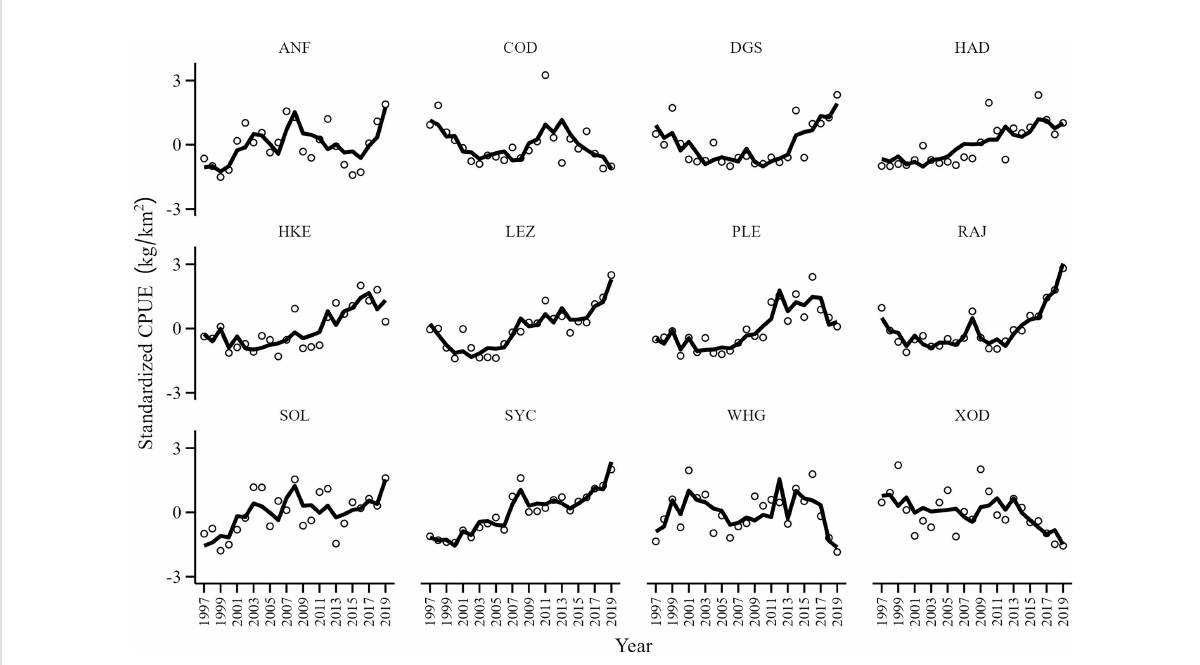
FIGURE 6 Observed values (open circles) and the model fi t (black line) obtained by the DFA model with one common trend, symmetrical non-diagonal matrix with mean exploitation rate (FER), cod exploitation rate (FERcod) and C. fi nmarchicus abundance (FIN) as covariates. Units are expressed as standard deviations from the mean.